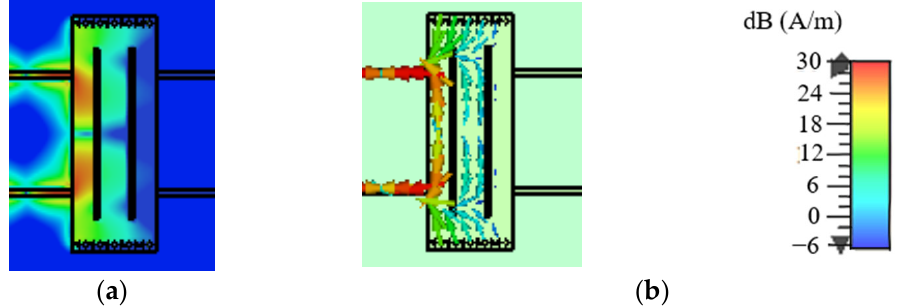
Figure 7. The surface current distributions on the SIW without slots for CM operating at f 0 . ( a ) The uniform amplitude distributions. ( b ) The vector distributions.